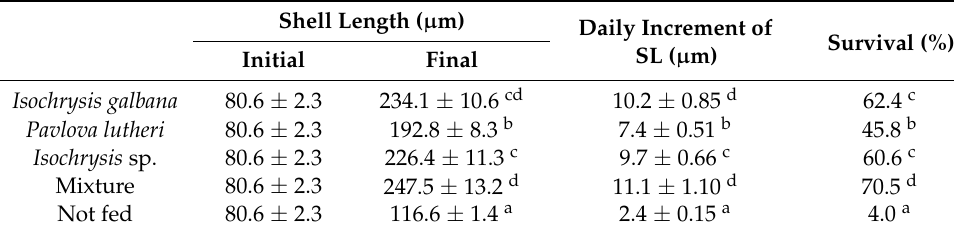
Table 3. The growth rate, daily increment of shell length (SL), and the survival rate of Mactra chinensis provided with a different microalgal supply for 15